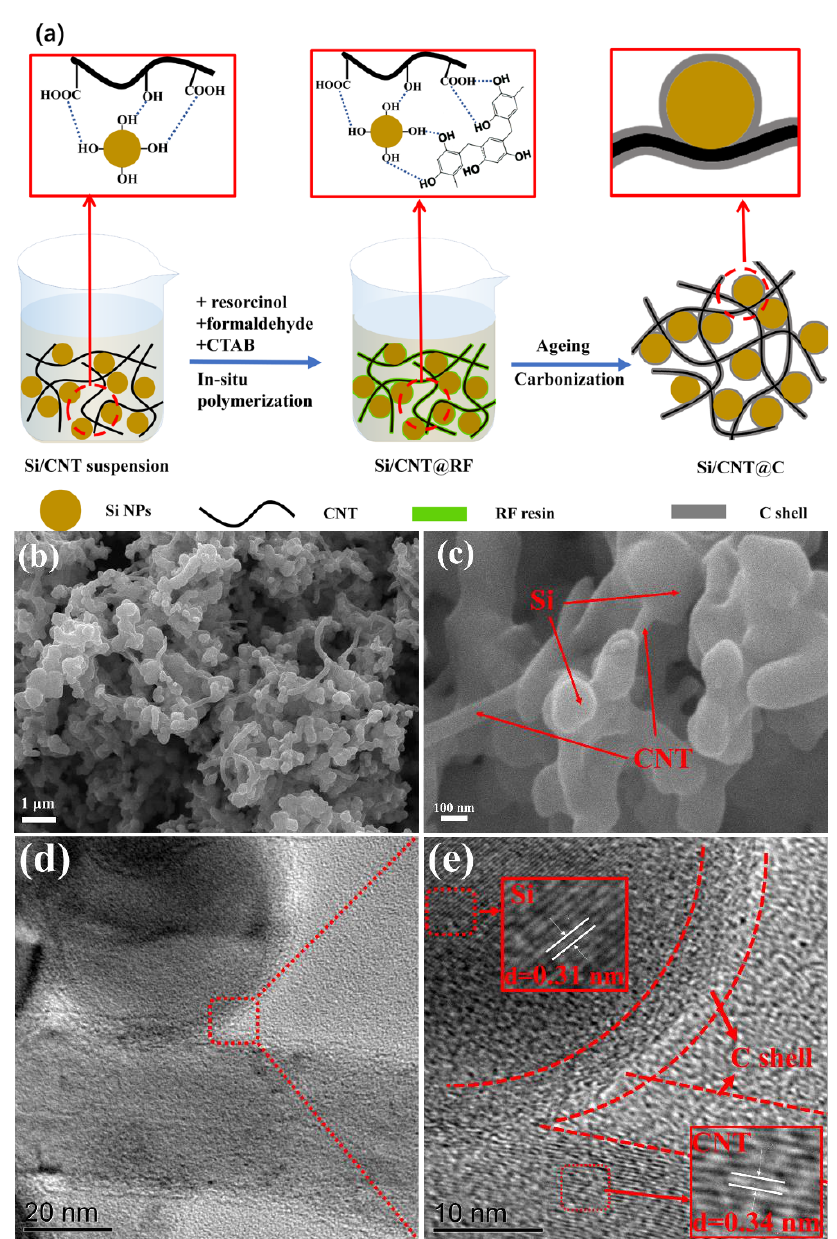
Figure 1. ( a ) Schematic illustration of the fabrication process, ( b , c ) SEM images, ( d ) TEM image, and ( e ) HR-TEM image of Si/CNT/C composite.